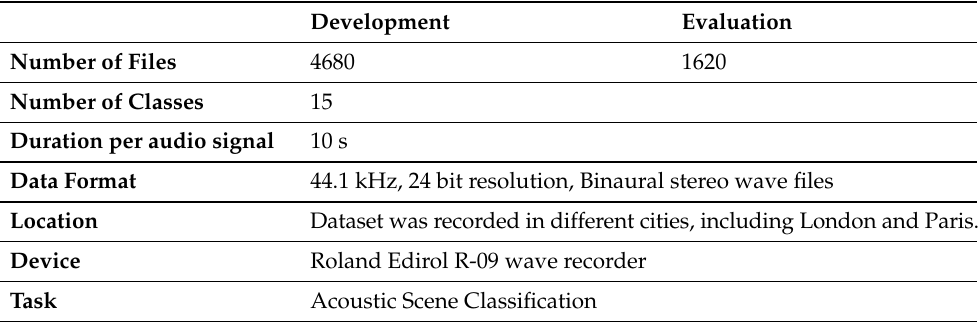
Figure 6. Block diagram of the test scheme of the proposed method. Table 1. Details of the TUT Acoustic Scenes 2017 (DCASE 2017 challenge) ASC